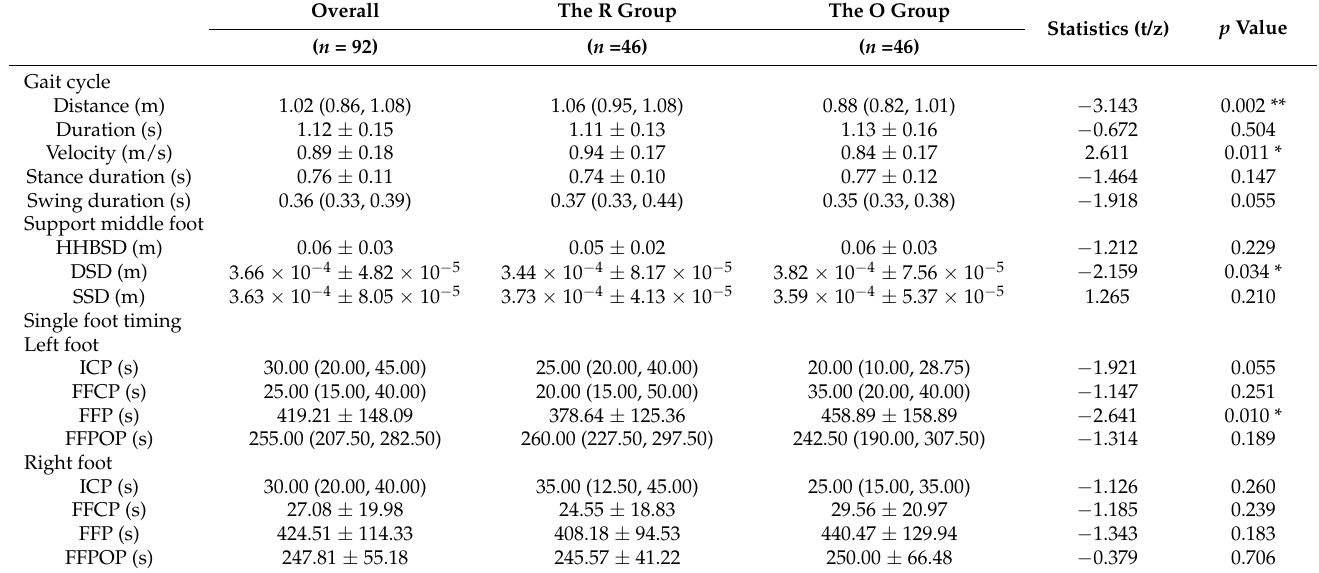
Table 3. Spatial-temporal gait parameters of the older women in the O and R groups.